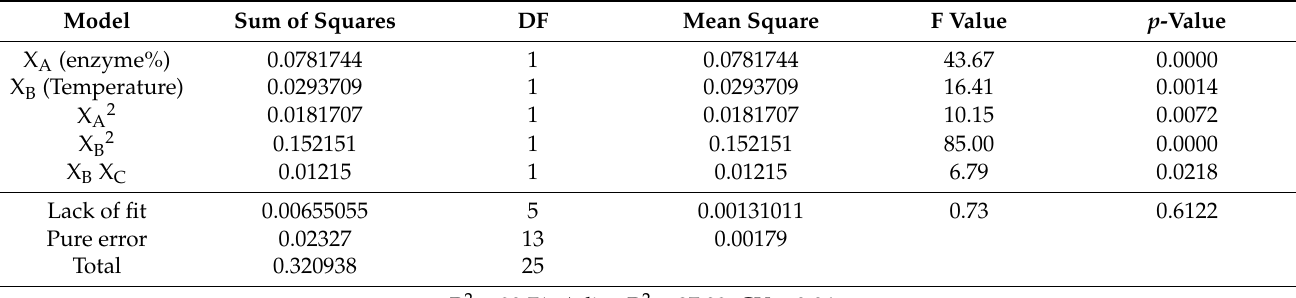
Table 9. Analysis of variance (ANOVA) for ORAC obtained for the corolase Box-Behken design.